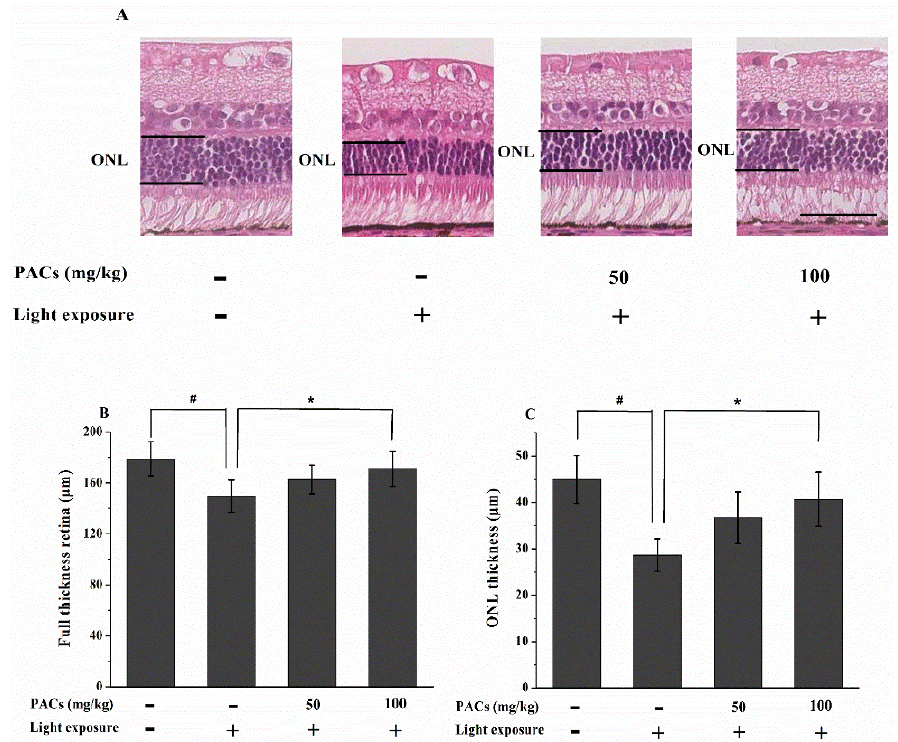
Figure 2. Effect of sea buckthorn seed PACs on the full thickness retina and outer nuclear layer (ONL) thickness in rabbits 7 d after light exposure (18,000 lx). ( A ) Representative images of the HE-stained sections of rabbit retinas. Scale bar: 50 µ m. ( B , C ) The full thickness retina and ONL thicknesses were measured within 250–2750 µ m (counted at 500 µ m intervals) of the superior and inferior edges from the ONH based on photographs of HE-stained sections by personnel blinded to the study groups. The full thickness retina and ONL thicknesses were calculated from 12 sections for each retina. Data are expressed as the mean ˘ standard deviation ( n = 8). (#, ˚ ) p < 0.05 (one-way ANOVA followed by Tukey’s